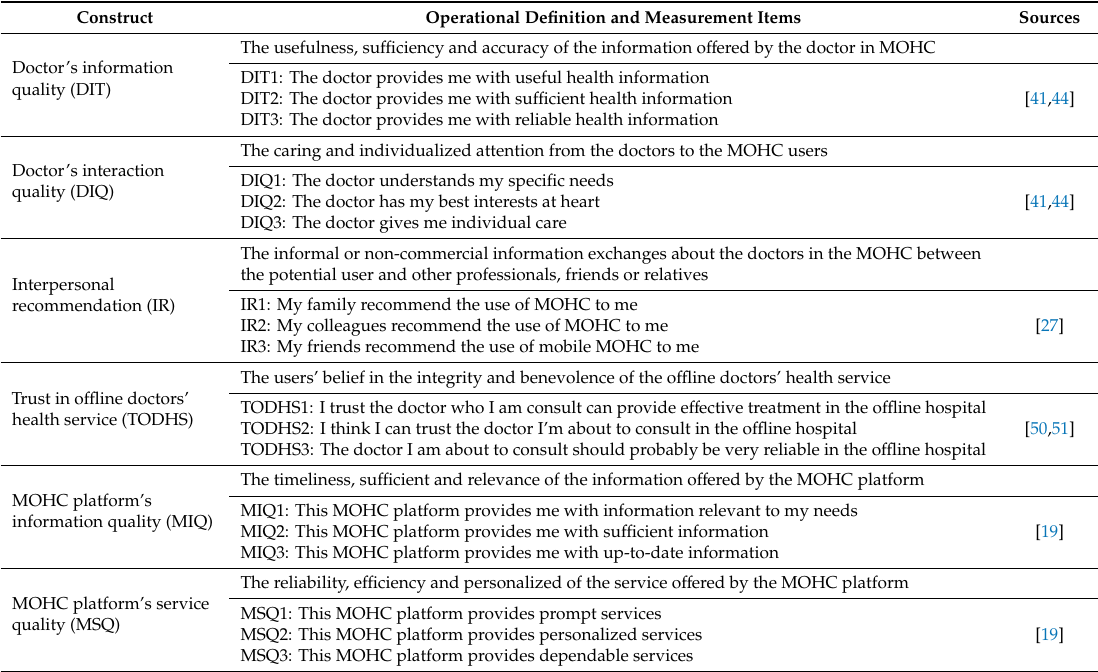
Table 2. Variable measurement and